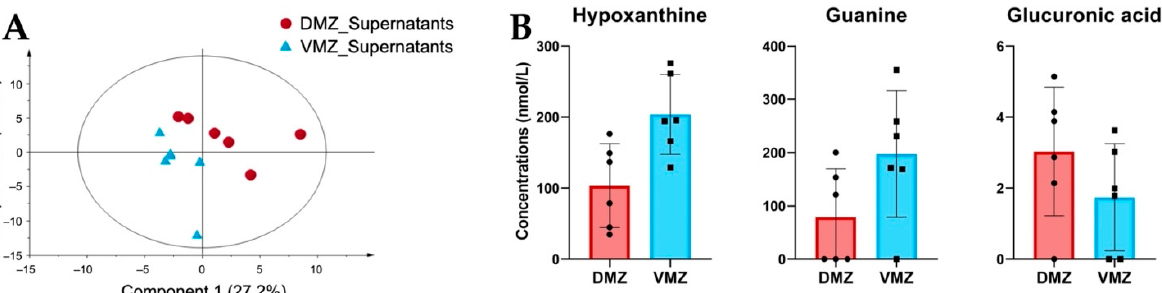
Figure 3. Comparative analysis of the characteristic hydrophilic metabolites identified in supernatants. ( A ) PLS ‐ DA score plots for the supernatants of the DMZ (red circle) and VMZ (blue triangle) samples (DMZ and VMZ supernatants) based on hydrophilic metabolite data. ( B ) Comparison of hypoxanthine, guanine, and glucuronic acid concentrations in the DMZ and VMZ supernatants. Symbols represent each sample and the bar graph indicates the mean ± SD ( n = 6, each sample from 20 explants).